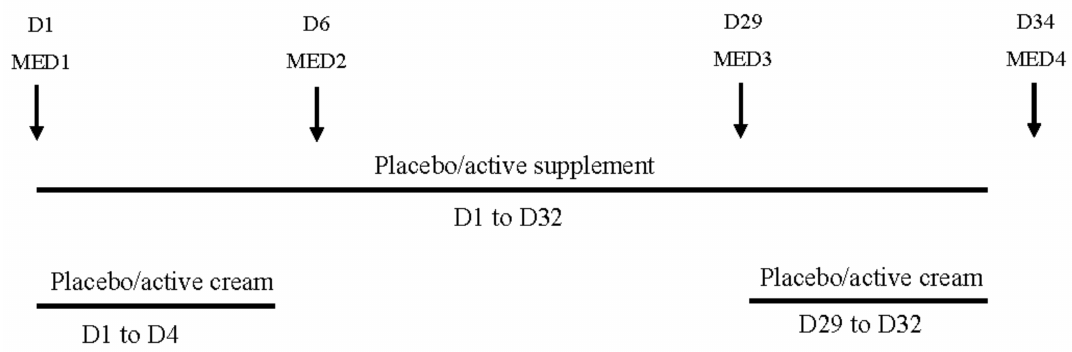
Figure 1. Schematic representation of the clinical study design. D : day; MED: Minimal Erythema Dose. Minimal Erythema Dose